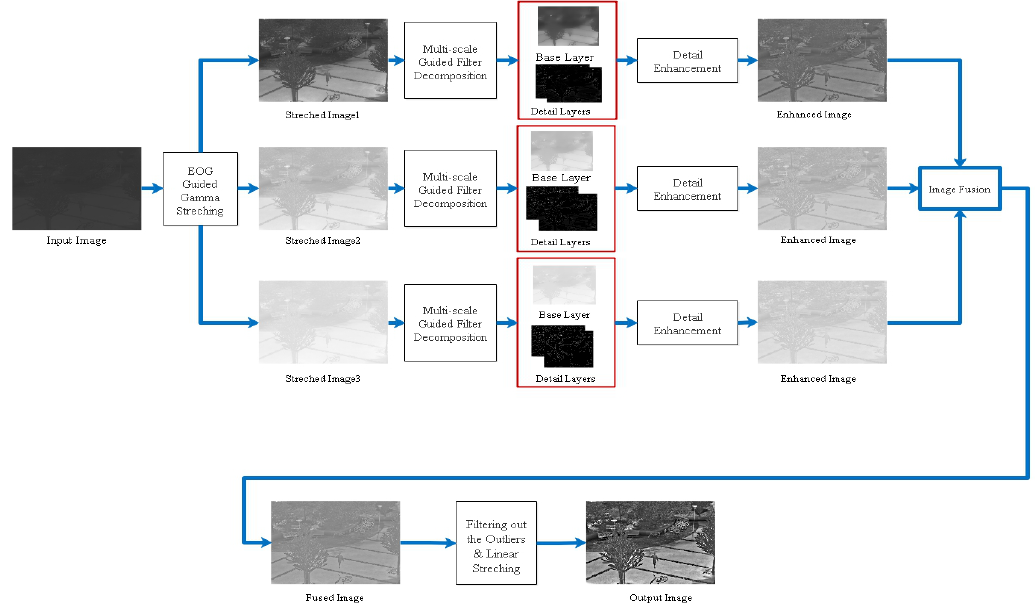
Figure 1. The proposed